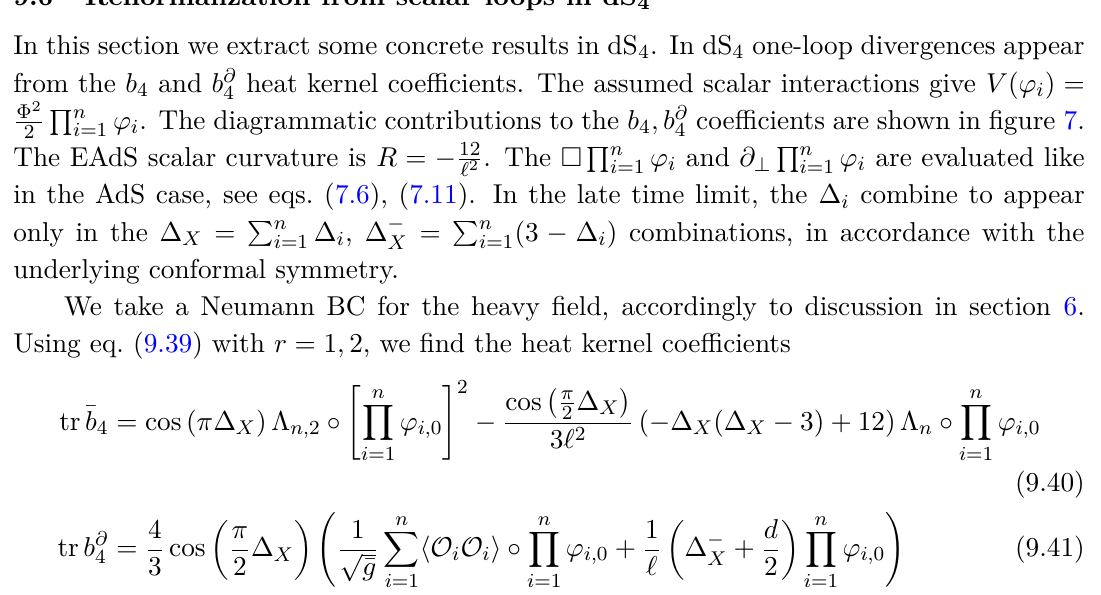
propagator EAdS 4